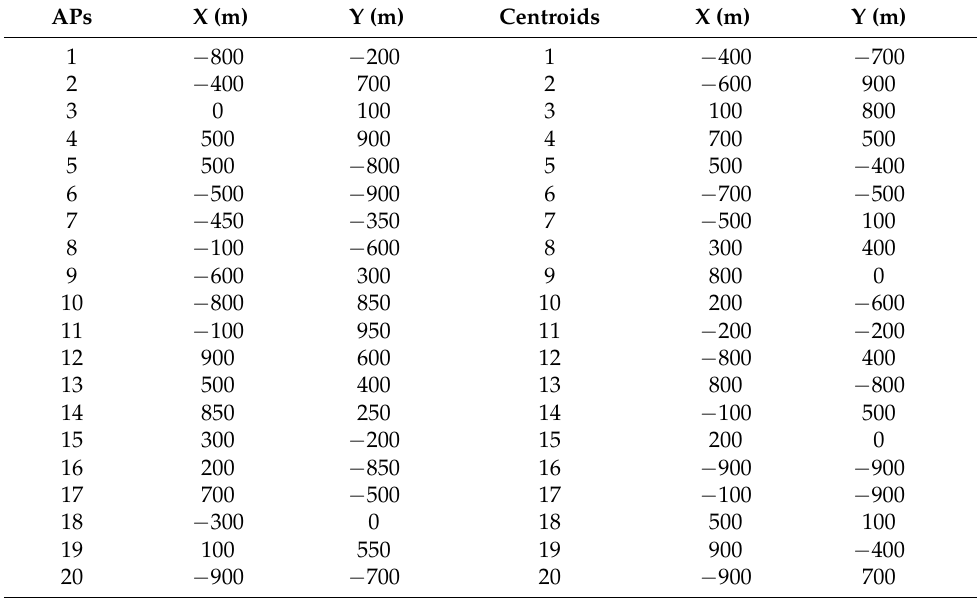
Table 1. Access points and centroid locations.